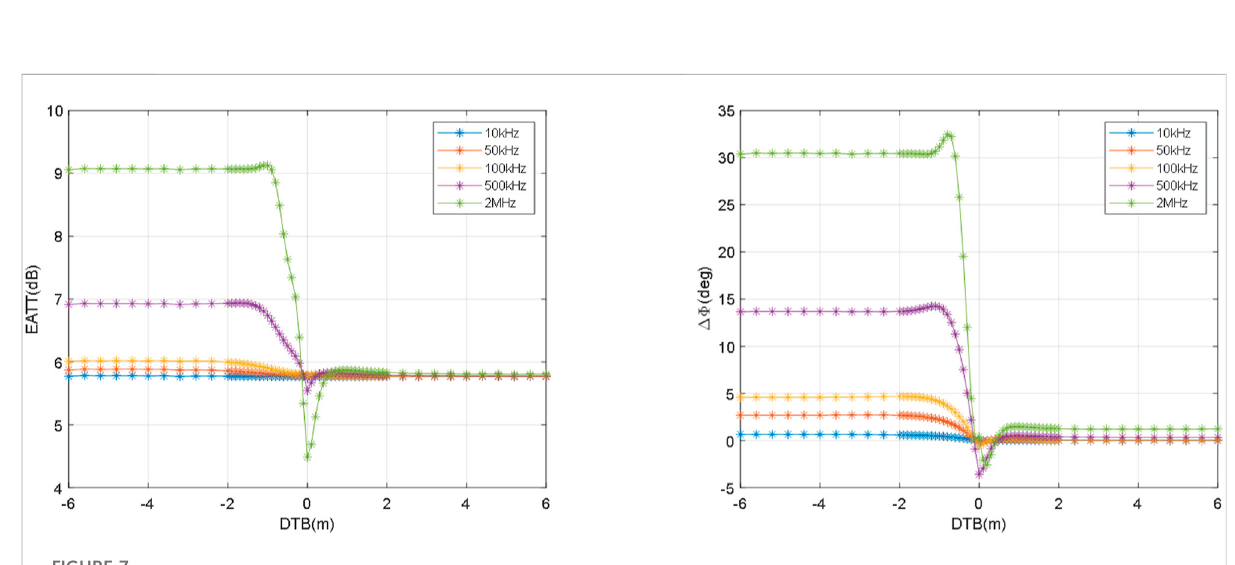
FIGURE 7 Response of the axial receiver at different